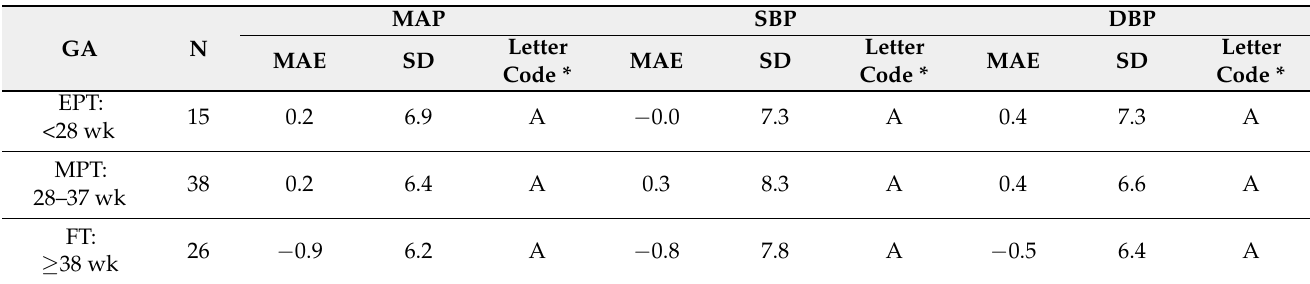
Table 7. Efficacy by gestational age.